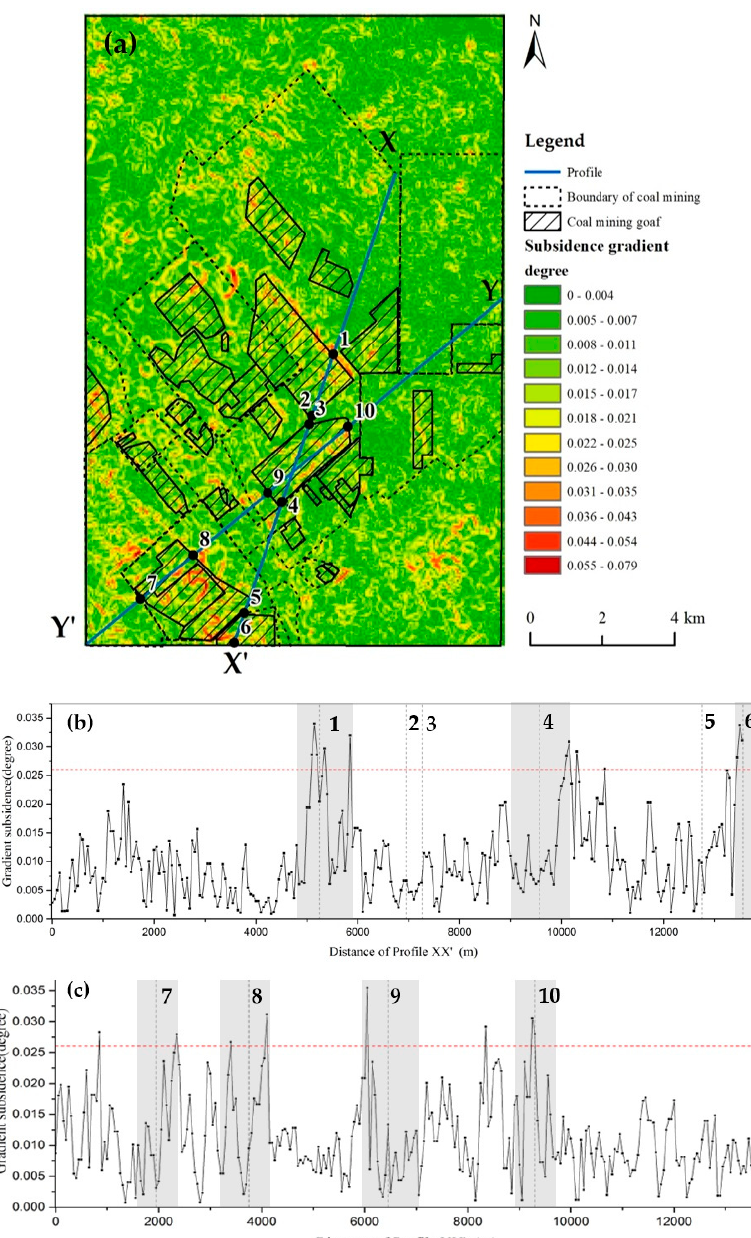
Figure 6. ( a ) Distribution of subsidence gradient during the period from 2006 to 2011; ( b , c ) the subsidence gradient along the lines of XX’ and YY’; The index number points were the intersection between the boundary of goafs and profile lines; The gray shaded area is the zone where the subsidence gradient exceeds 0.026 around the junction of the goaf boundary with two profile lines.